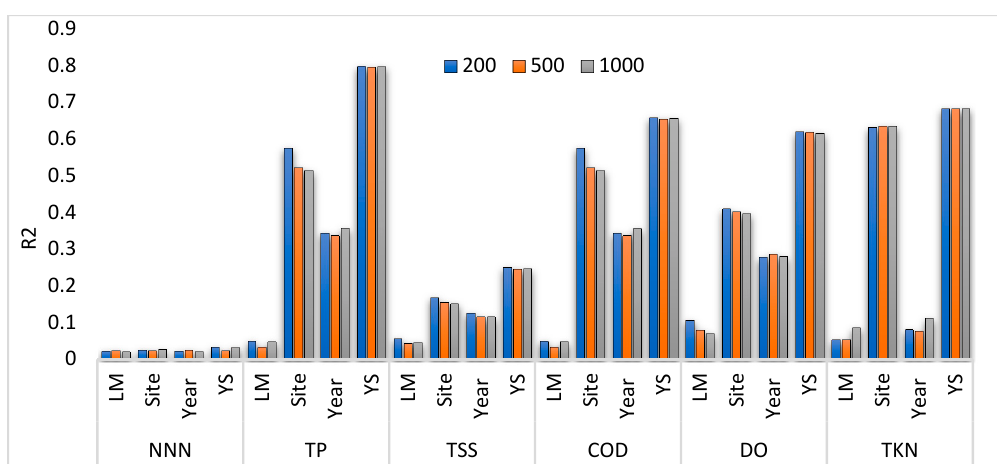
Figure 6. The adjusted R 2 of multiple regression models describing the strong associations between land use and water quality across riparian scales (200 m, 500 m, and 100 m) and different models, with the water quality parameters NNN, TP, TSS, COD, DO, and TKN.